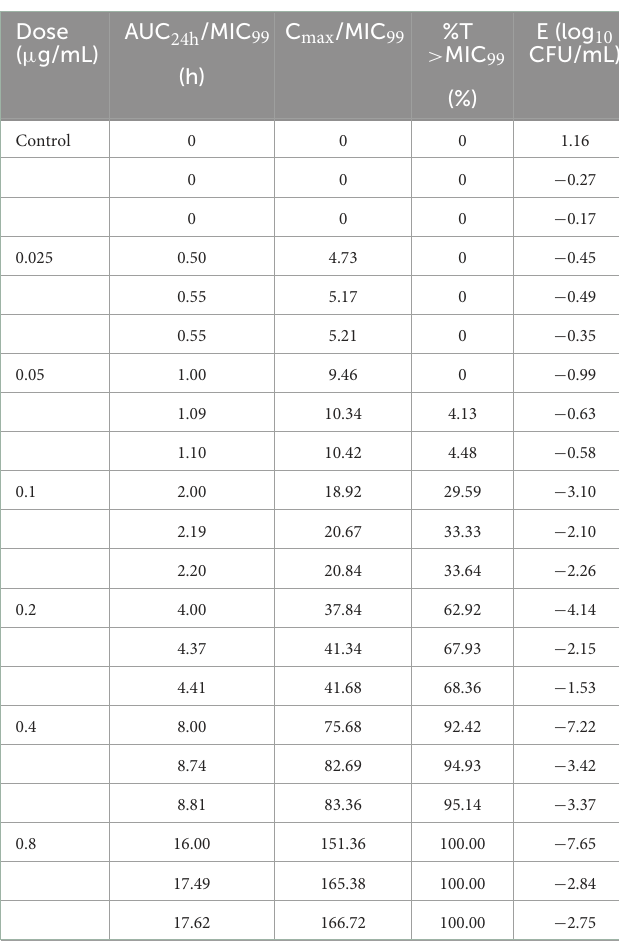
TABLE 1 Values of the antibacterial effect (E) and PK/PD parameters of danofloxacin against Actinobacillus pleuropneumoniae after three-times